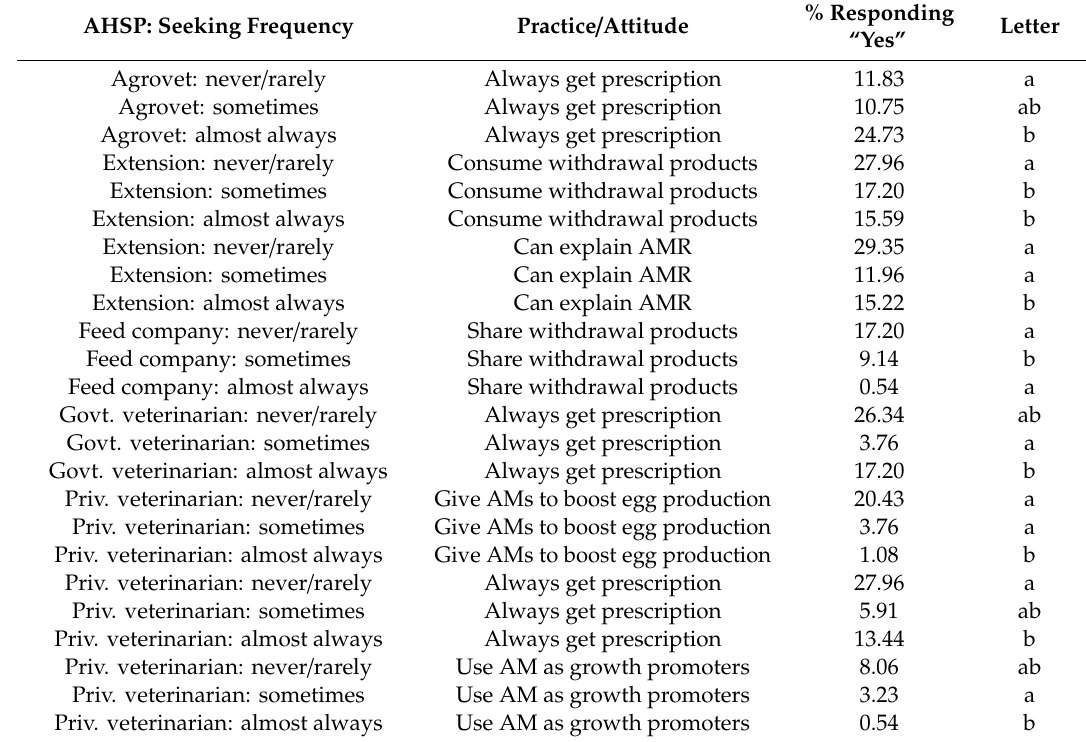
Table 6. Significant di ff erences in prudent knowledge, attitudes, and practices across health-seeking frequencies. The first column reports the animal health professional (AHSP) followed by the frequency of seeking health advice from that AHSP. The second column reports the practice or attitude included in the Fisher’s exact test. The third column reports the percentage of people who reported seeking a certain frequency who responded “yes” to the practice or attitude. For example, in the second row, 11.83% of respondents who reported going to an agrovet “never / rarely” said they always get a prescription (i.e., “yes”). The fourth column represents whether significant di ff erences exist across the health-seeking frequencies on a practice / attitude. Frequencies (i.e., never / rarely, sometimes, almost always) that share a letter are not significantly di ff erent by Fisher’s exact test p -values adjusted by the Benjamini–Hochberg false discovery rate for multiple comparisons [19]. See text for additional explanation and